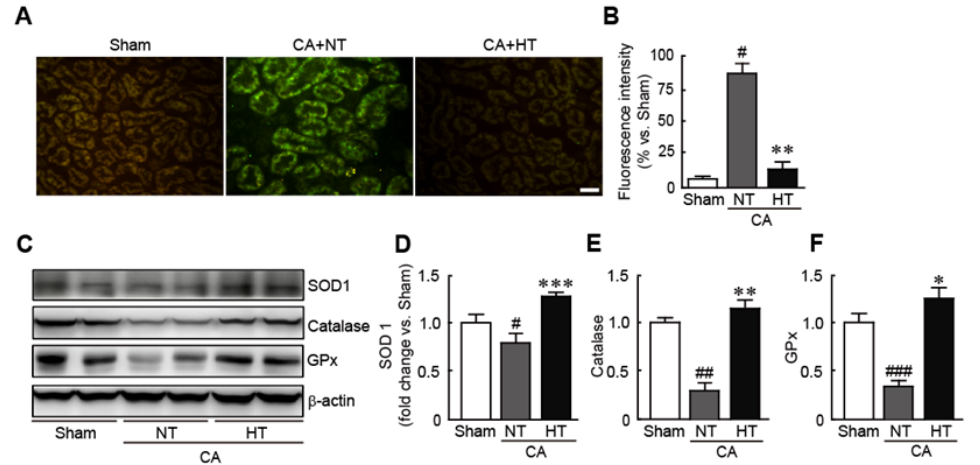
Figure 5. Olanzapine-induced TH inhibits CA-induced oxidative stress in renal tissues. Reactive oxygen species production stained with DCFH-DA ( A ) and fluorescence intensity ( B ) in renal tissues after CA and ROSC with or without olanzapine-induced TH. ( C – F ) Western blot analysis for measuring the expression levels of SOD1, catalase, GPx, and β -actin proteins ( n = 3 per group). Significance is represented as # p < 0.05, ## p < 0.01, and ### p < 0.001 vs. the sham group; * p < 0.05, ** p < 0.01, and *** p < 0.001 vs. the CA + NT group. CA, cardiac arrest; TH, therapeutic hypothermia;